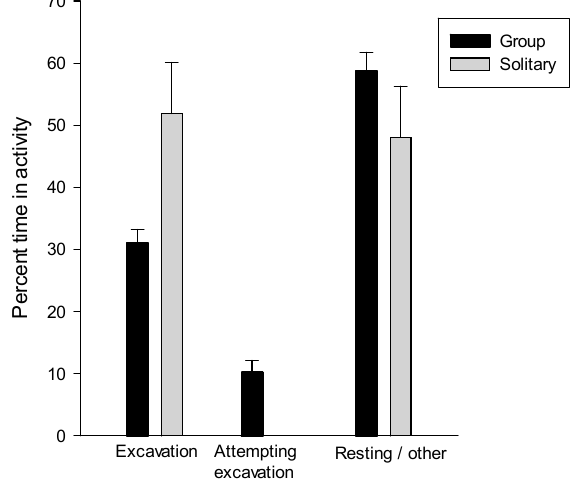
Figure 6. Percent of time spent in different activities by solitary and grouped caterpillars. See also Video S1.